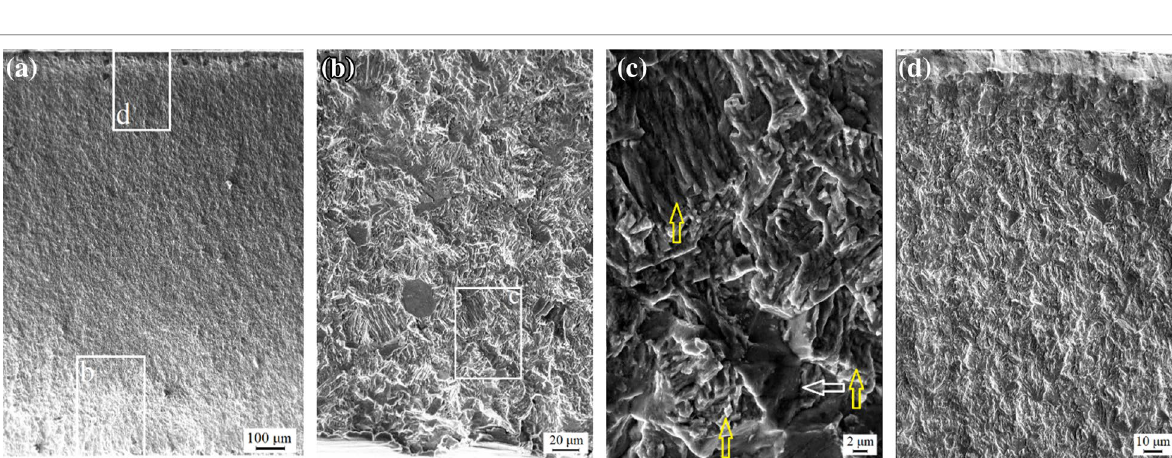
10 6 cycle, b 0.8 ×